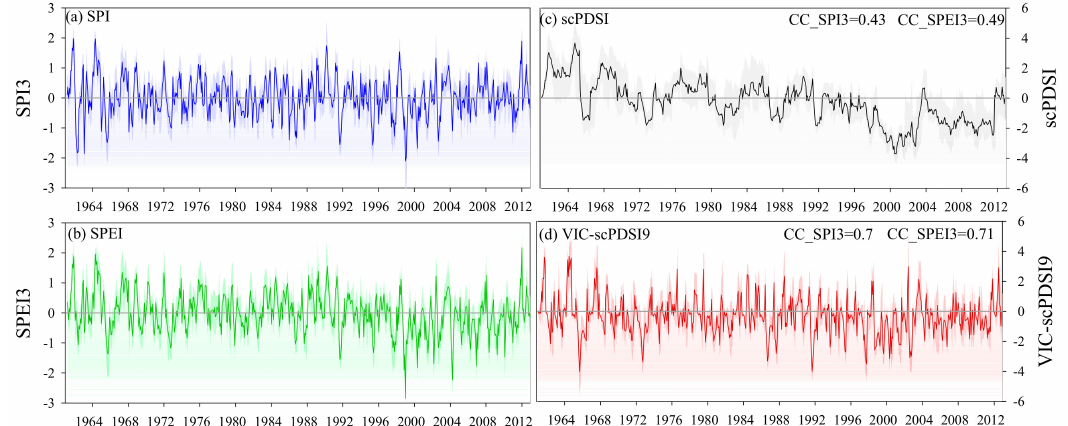
Figure 6. Time series of ( a ) SPI, ( b ) SPEI, ( c ) scPDSI, and ( d ) VIC-scPDSI9 values averaged over the whole YRB. The shadows denote the 25th–75th percentile range of index values over